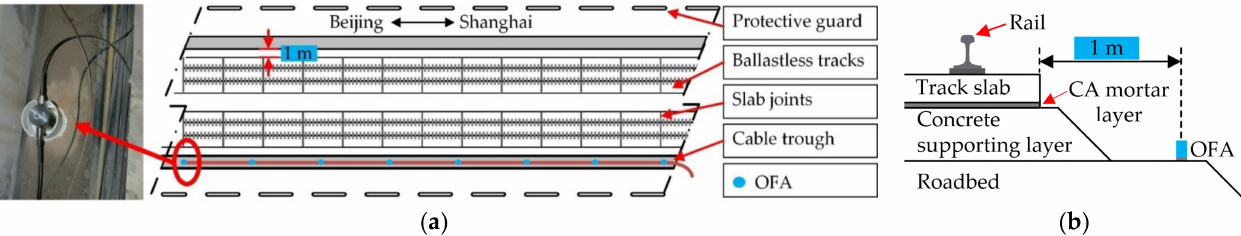
Figure 3. Arrangement of optical fiber accelerometers. ( a ) Top view. ( b ) Cross-section view. OFA (Optical fiber accelerome- ter); CA (cement